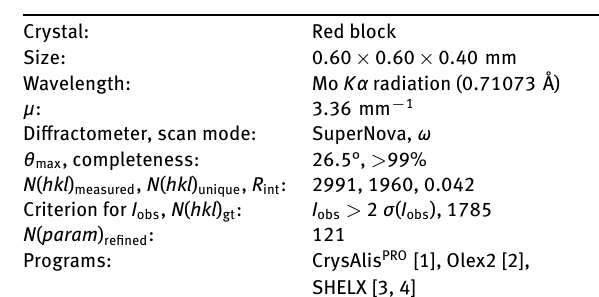
Figure 1: A view of the molecule. Displacement ellipsoids are drawn at the 50% probability level and H atoms are shown as small spheres of arbitrary radii.